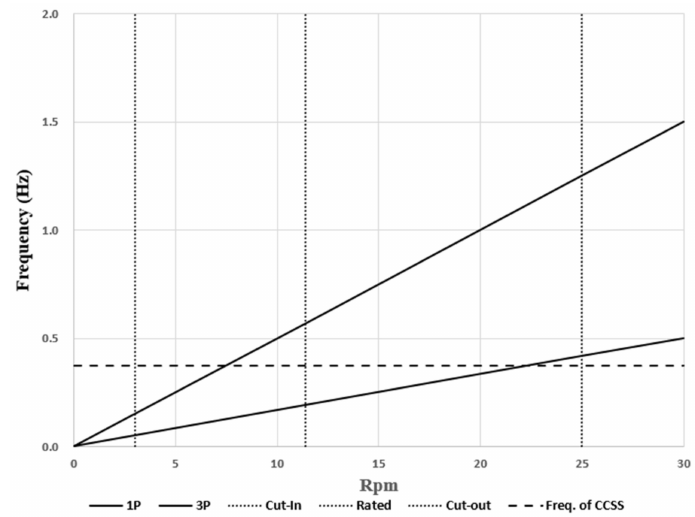
Figure 13. Design ranges for the fundamental frequencies of the support structure with the WinDS3000